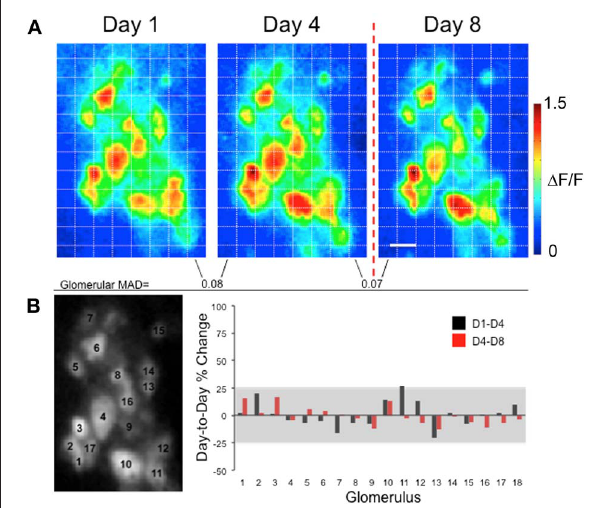
FIGURE 3 | Presentations of foot shock alone do not significantly alter glomerular G-CaMP2 odor representations in individual mice. (A) Methyl valerate response maps taken from the same animal across several days. Maps from Day 1 to Day 4 were taken prior to any conditioning and were similar across the days. The last map (Day 8) was taken one day after exposing the animal to presentations of shock only. No dramatic changes in response amplitude were seen in glomeruli on the day following the foot shock. The Mean Absolute Day-to-Day Difference (MAD) for each glomerulus remained similar before and after training. Scale bar: 100 μ m (B) The left panel indicates the position of the glomeruli. The graph shows the percent change in response for each glomerulus across days. The gray box represents the pre-training percent change (mean ± 2SD) taken from all glomeruli across all three groups. As can be seen in this example, the pre- and post-training changes in individual glomerular responses, while variable, did not exceed this